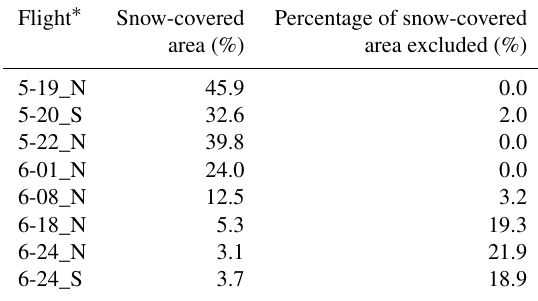
Table 4. Summary of areas excluded due to erroneous points with respect to snow-covered area at the alpine